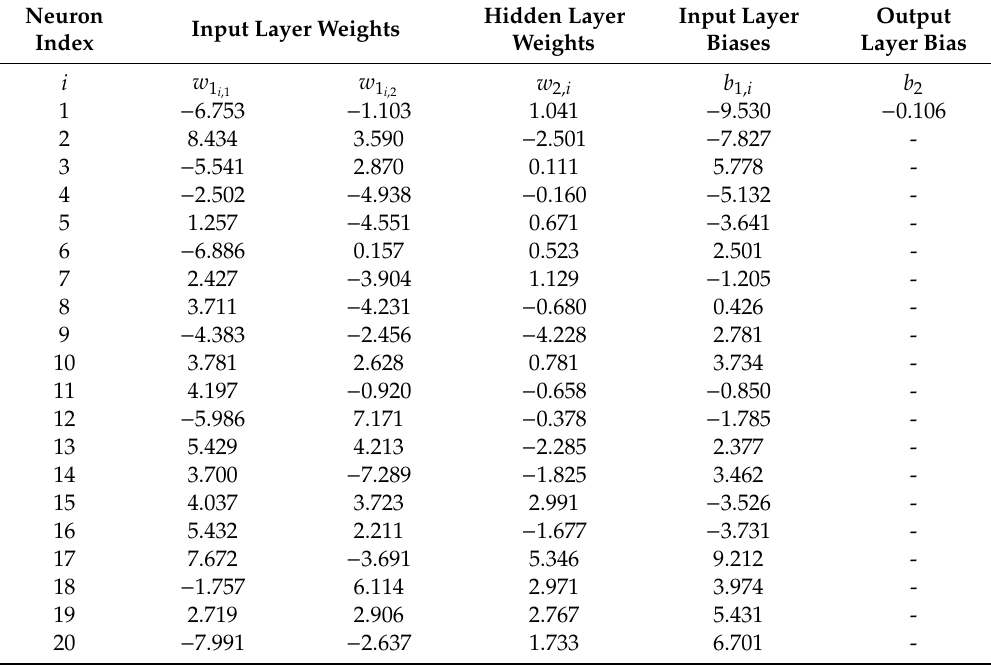
Table 8. The optimized coe ffi cients for estimating the normalized k n in Equation (25).